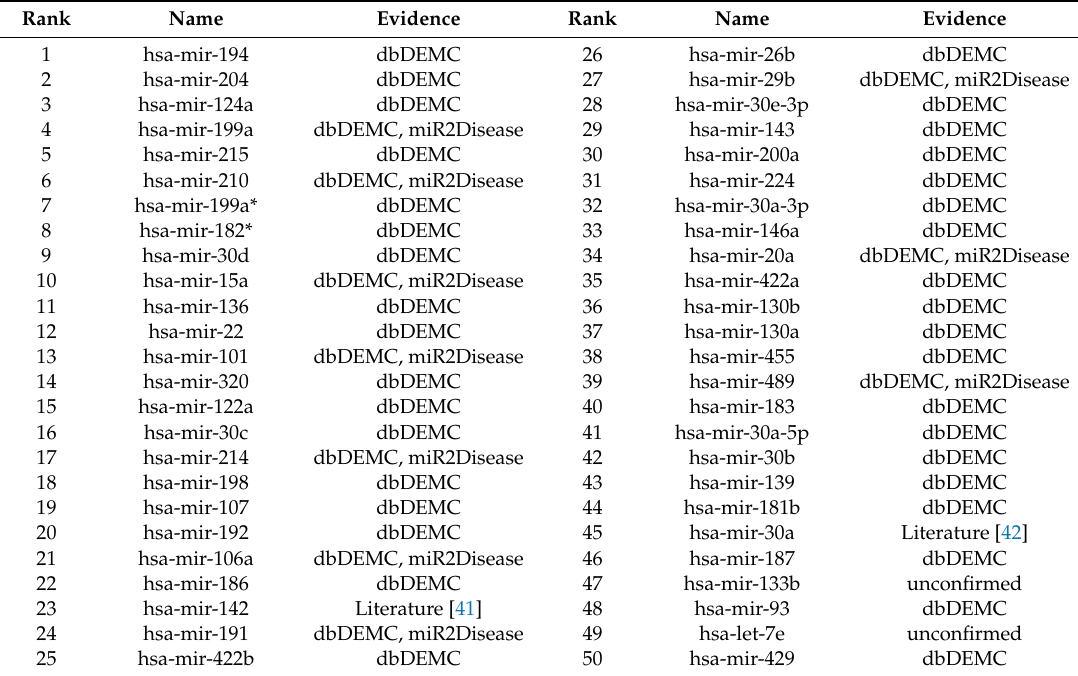
Table 3. Prediction of top 50 kidney neoplasms